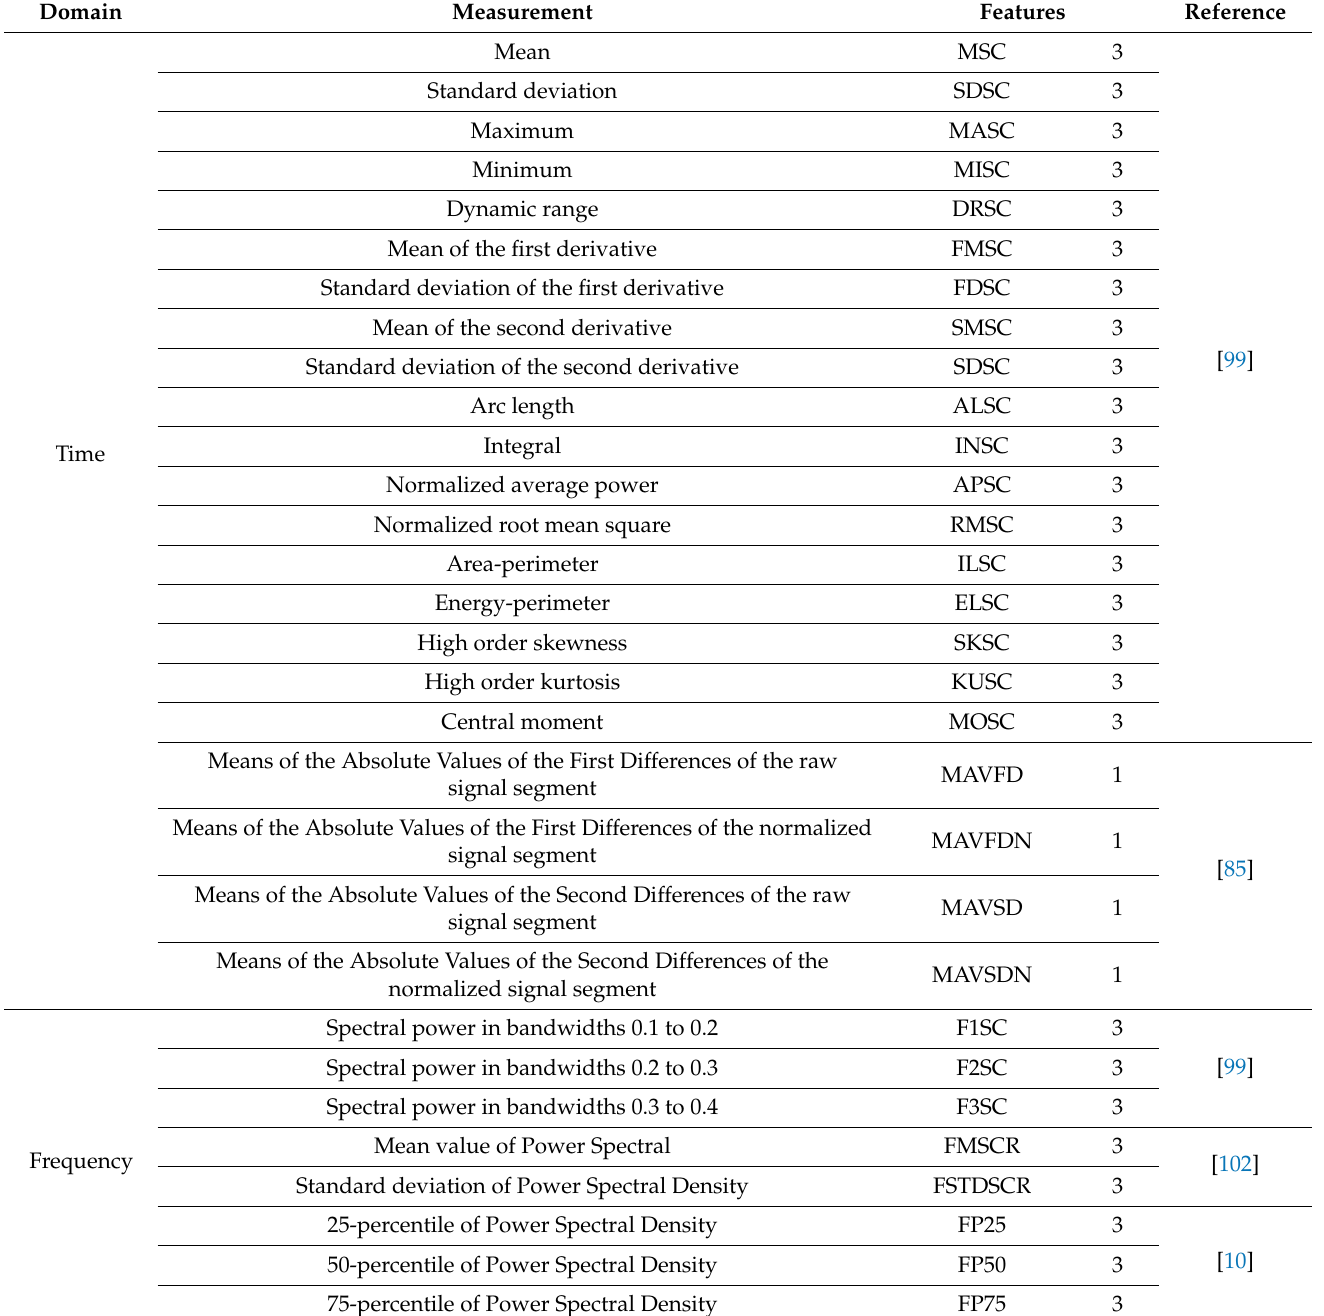
Table 10. Electrodermal activity